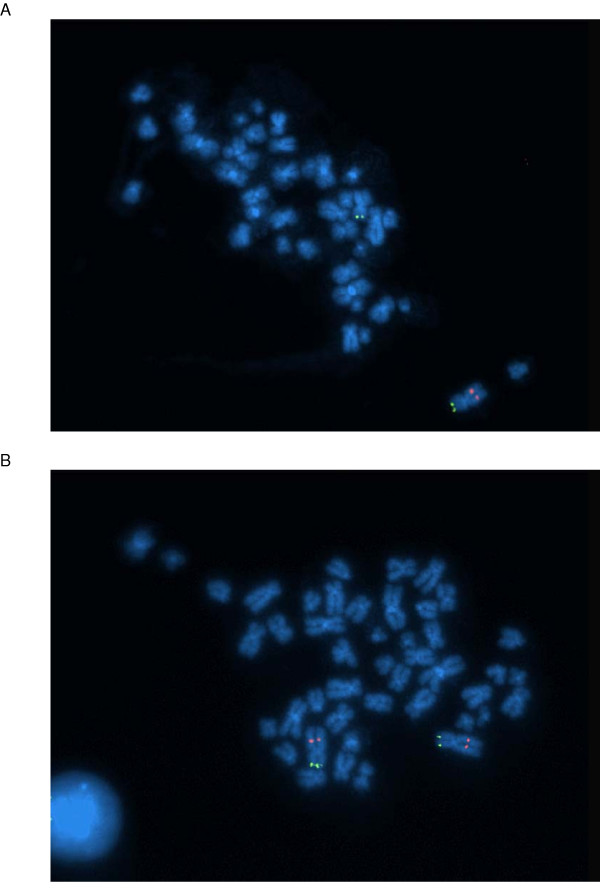
FISH result showing mosaicism for a chromosome 2 microdeletion. SNPscanPlot analysis suggested a microdeletion in chromosome 2q of case NA07055. 16 of 23 cells revealed a deletion (an example is shown in A), while the remainder appeared euploid (B).